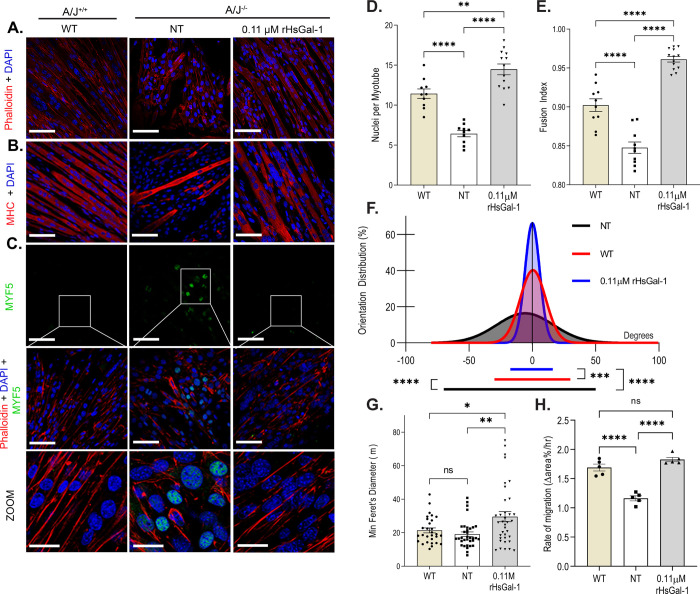
rHsGal-1 treatment increases levels of fusion index and myotube maturity.A. Representative images of A/J cells cultured and immunostained with Phalloidin (red) and DAPI (blue). B. Representative images of A/J cells cultured and immunostained with MHC (red) and DAPI. C. Representative images of A/J cells cultured and immunostained with Myf5 (green), Phalloidin, and DAPI. D. Average number of nuclei per myotube compared between WT (n = 1608 nuclei, 187 myotubes, 10 fields), NT (n = 1587 nuclei, 215 myotubes, 9 fields), and 0.11 μM rHsGal-1 treated (n = 2476 nuclei, 166 myotubes, 13 fields) groups E. Fusion index between WT, NT, and 0.11μM rHsGal-1 treated myotube groups. F. Myotube alignment along the major axis compared between WT (n = 50 myotubes, 10 fields), NT (n = 49 myotubes, 9 fields) and 0.11 μM rHsGal-1 treated (n = 75 myotubes, 13 fields) myotubes. G. Minimum Feret’s diameter measurements between WT (n = 30 myotubes, 10 fields), NT (n = 34 myotubes, 9 fields), and 0.11μM rHsGal-1 treated (n = 36 myotubes, 13 fields) myotubes. H. Rate of migration between WT, NT, and 0.11μM rHsGal-1 treated myoblast groups. p values are measured by Tukey’s multiple comparison test and indicated by **p<0.01 and ****p< 0.0001. Error bars represent SEM. Scale bar = 100 μm.